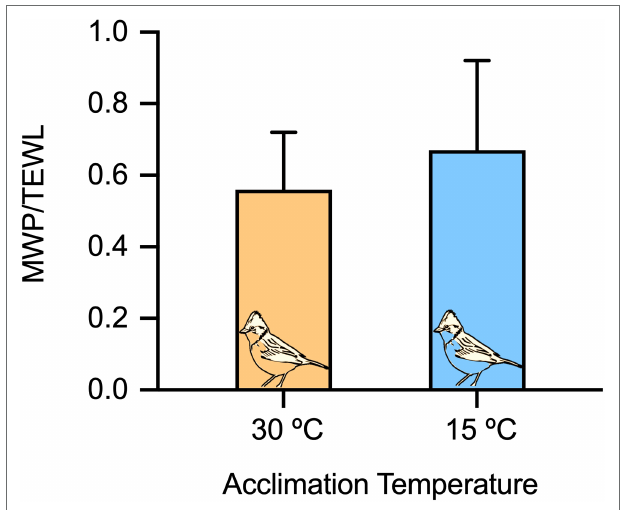
FIGURE 1 | The ratio between metabolic water production estimated from RMRs and total evaporative water loss in Z. capensis at 15 ° C and 30 ° C ambient temperature. Error bars in each panel represent SD